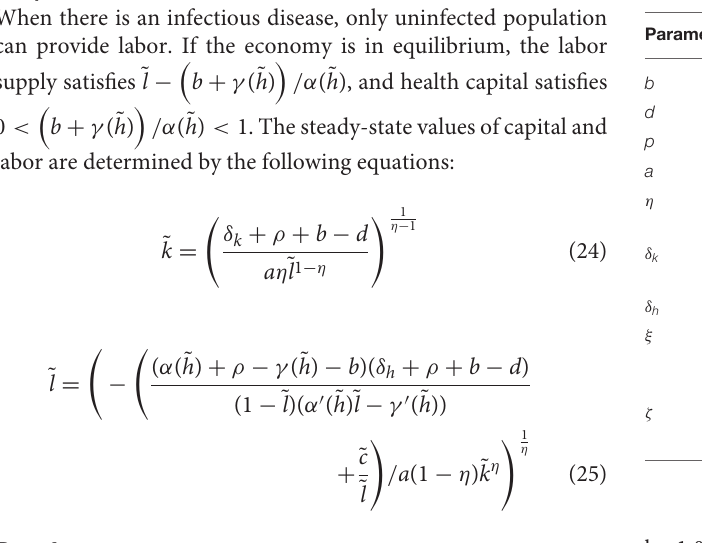
TABLE 1 | Model parameter